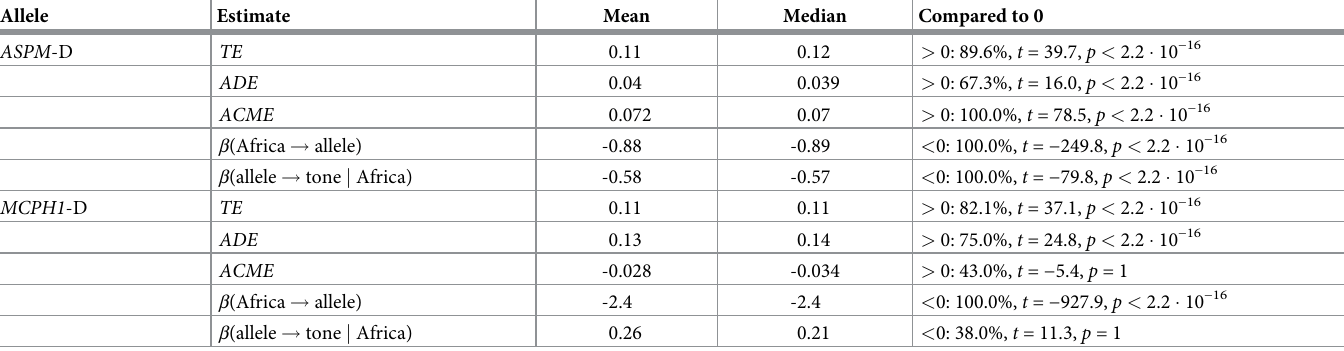
Table 11. Summaries of the mediation analysis for 1,000 restricted samples for tone2 . Same conventions as in Table 9. Allele Estimate